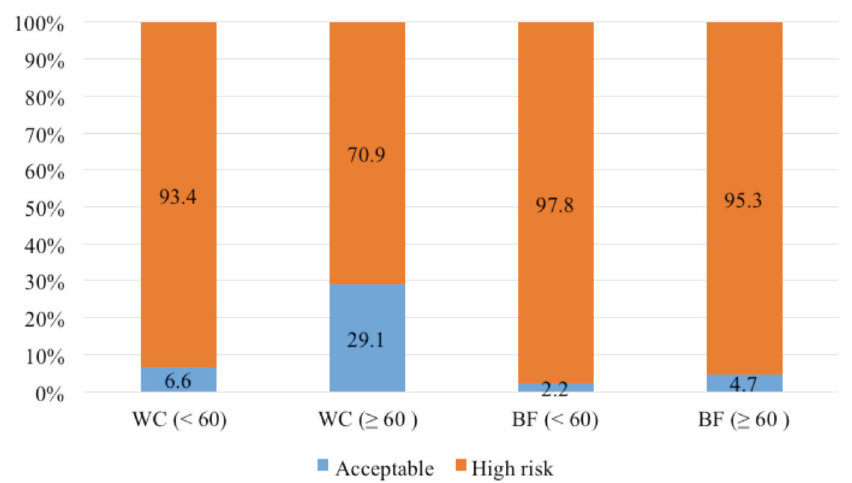
Percentage of WC and BF compared to cut-off value for patients < 60 years old (n = 45) and patient aged ≥ 60 years (n = Fig. 4: